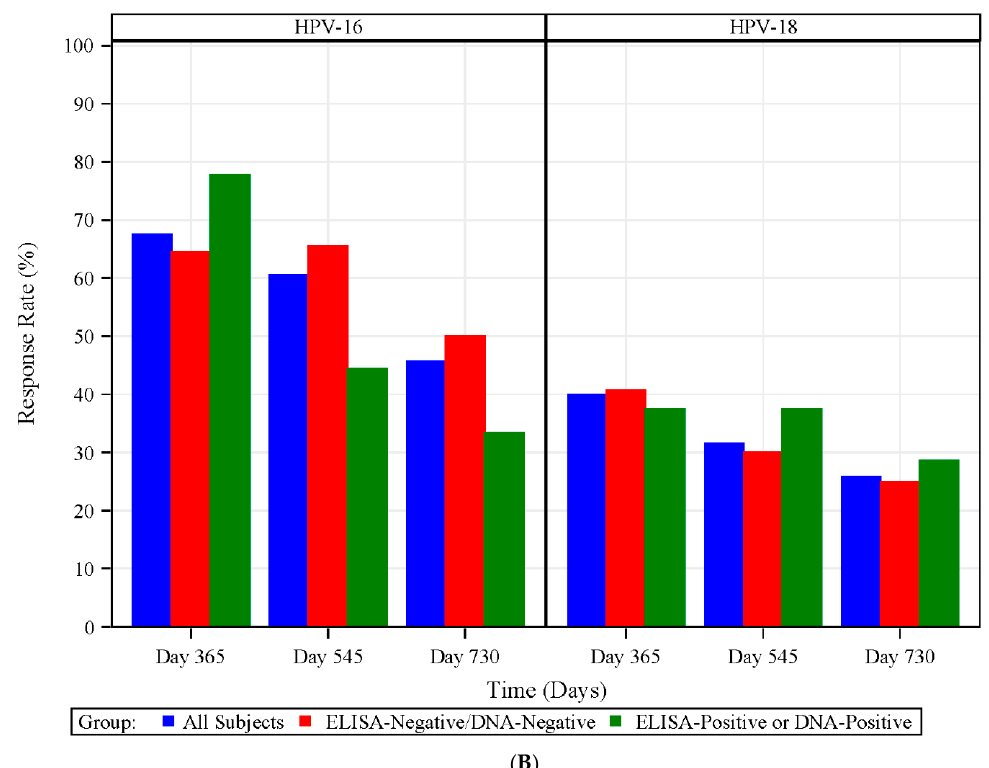
Figure 5. Frequency and proportion of MBC responders induced by 4vHPV. (A) Frequency of HPV-16- (left panel) and HPV-18-specific (right panel) specific memory B cells (MBCs) per millions of total IgG-secreting B cells at Days 0, 365, 545 and 730 in the prospective cohort for all (solid blue line), HPV-naïve (dashed red line) and HPV-exposed (dashed green line) subjects; (B) proportion of MBC responders (defined as subjects with >455 L-16 B cell or >450 L-18 B cell per millions of total IgG-secreting B cells) to HPV-16- (left panel) and HPV-18- (right panel) in the prospective cohort at Days 365, 454 and 730 as indicated at x-axis for all (blue bar), HPV-naïve (red bar) and HPV-exposed (green bar) subjects. For the retrospective cohorts, the GM of MBC magnitudes were similar between the cohorts. (306 vs. 241 per 10 6 total IgG-secreting B cells for HPV-16 and 90 vs. 74 for HPV-18, Retro 2; vs.